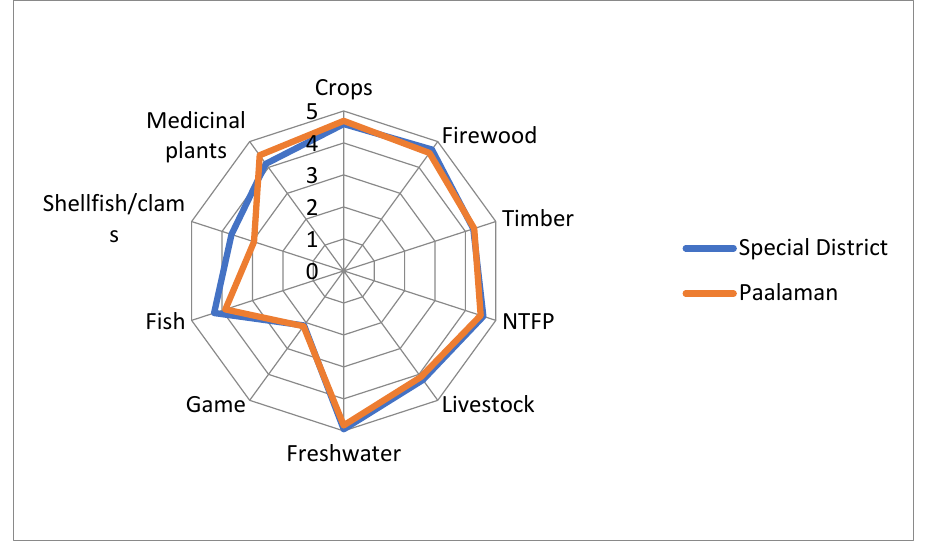
Figure 4. Average importance of different ecosystem services for each household (N = 90) in the two villages (Special District and Paalaman).